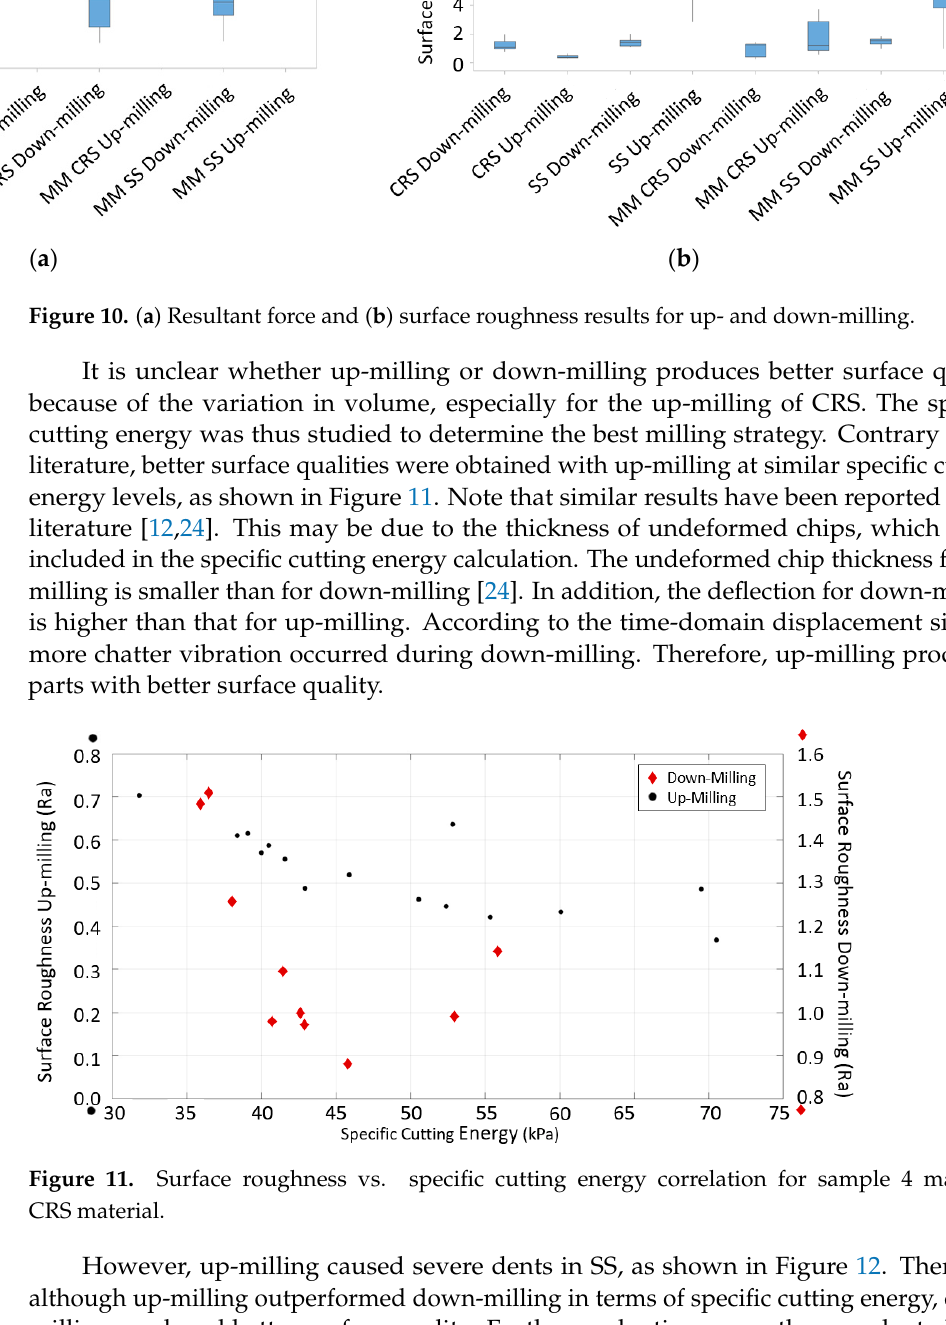
Figure 12. Macro dents on machined surfaces obtained with up ‐ milling. 3.3. Evaluation of Axial Depth of Cut This study used two axial depths of cut values, 1.5 and 3 mm, for machining the parts. As shown in Figure 13a, although the 3 mm axial depth of cut removed more local ma ‐ chined volume in general, the local machined volumes for the two axial depth of cut val ‐ ues were similar for most cases. The surface roughness due to the fact of machining was also compared for the two axial depths of the cut. As shown in Figure 13b, there was no apparent difference in the surface roughness between the two axial depth of cut values. For box plot preparation, the upper limit is obtained when the third quartile value and 1.5 times the interquartile range value are summed. According to the limit, extreme outliers are marked with an asterisk (*) on the boxplot. The local actual machined volume was thus used instead of the axial depth of cut in this study.